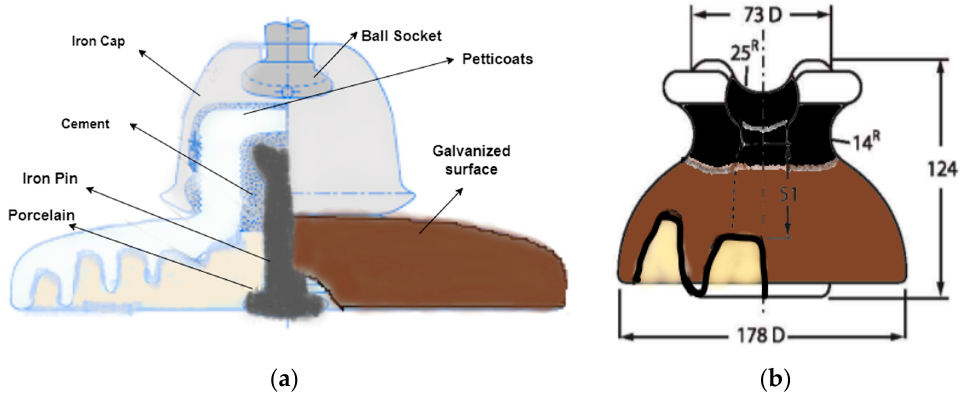
Figure 6. Internal structure of pin and suspension disc porcelain insulators: ( a ) internal structure of a suspension disc insulator, ( b ) the length parameters of the pin insulators.